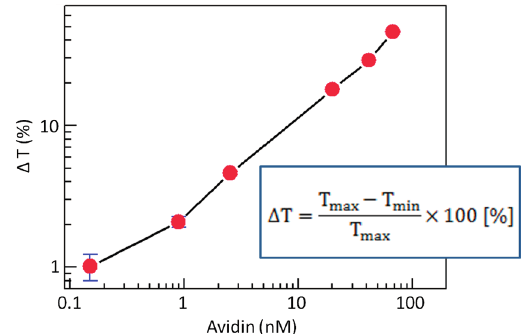
Figure 16. A graph of transmitted light ration vs. the concentration of avidin added into biotinylated 200 nm-diameter particles’ solution. Adapted from